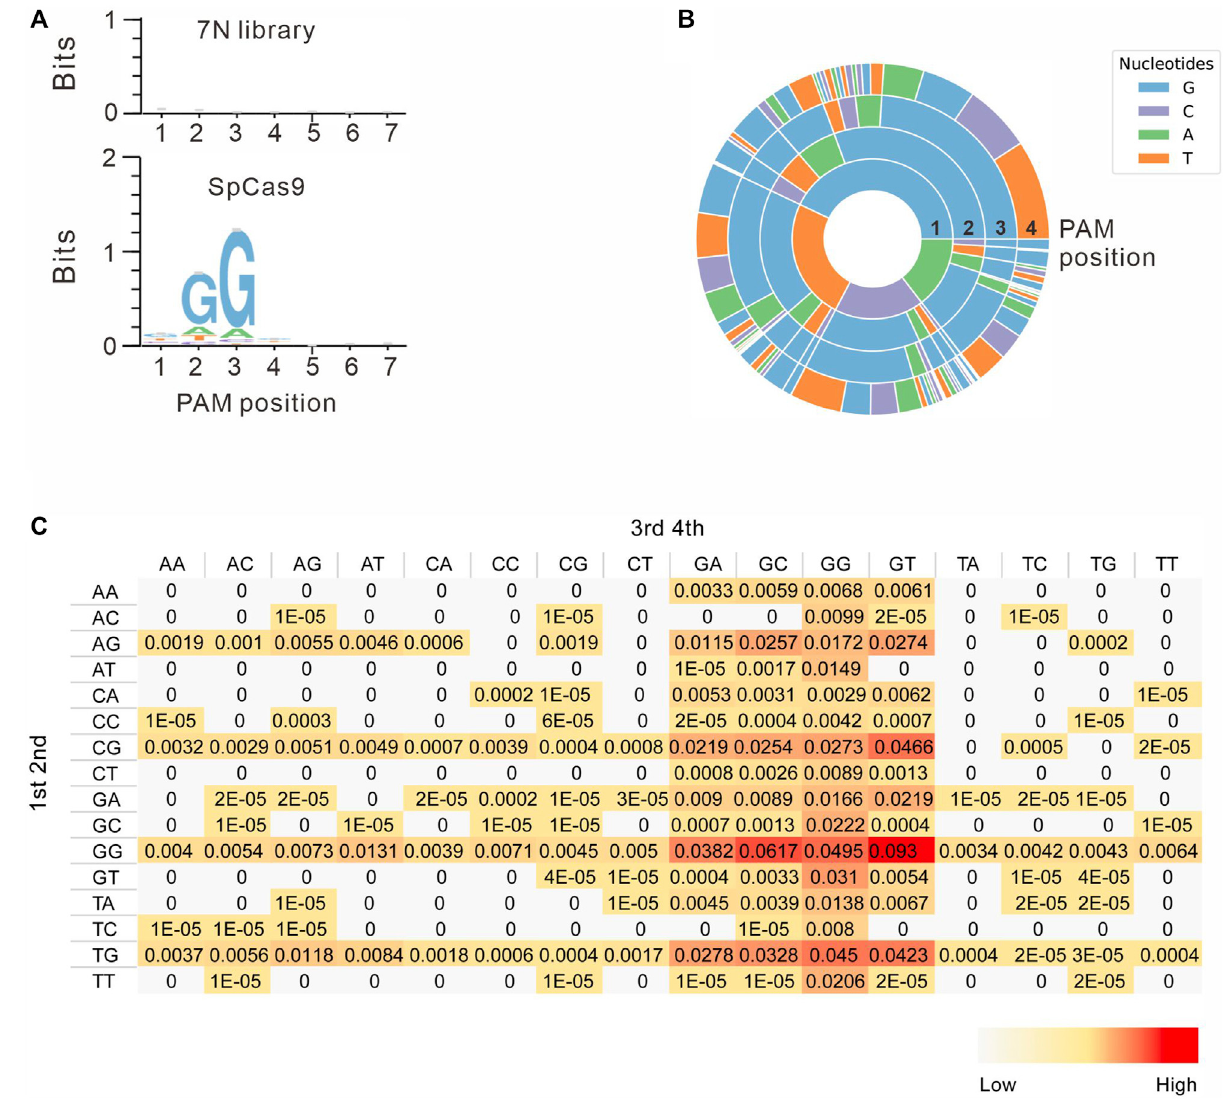
Frontiers in Cell and Developmental Biology |